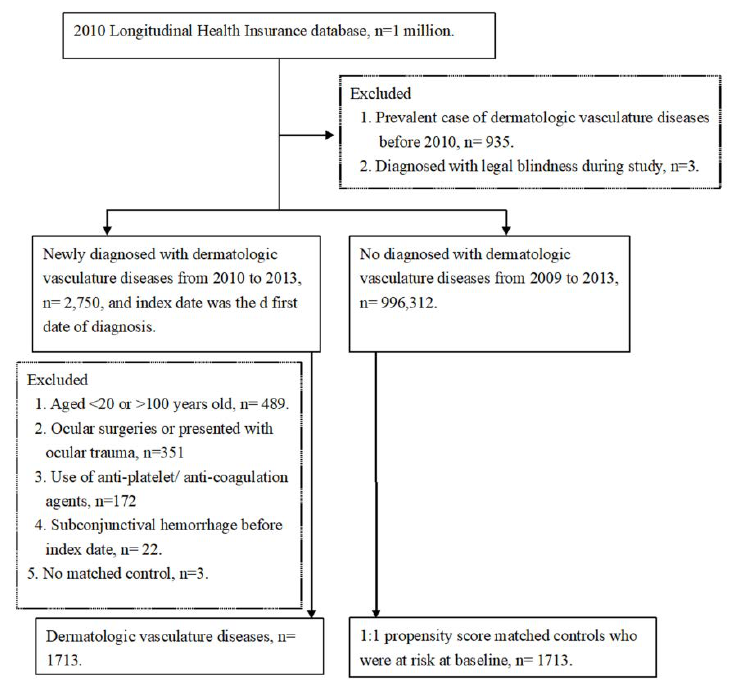
Figure 1. Flowchart of patient enrollment with and without dermatologic vasculature disease.